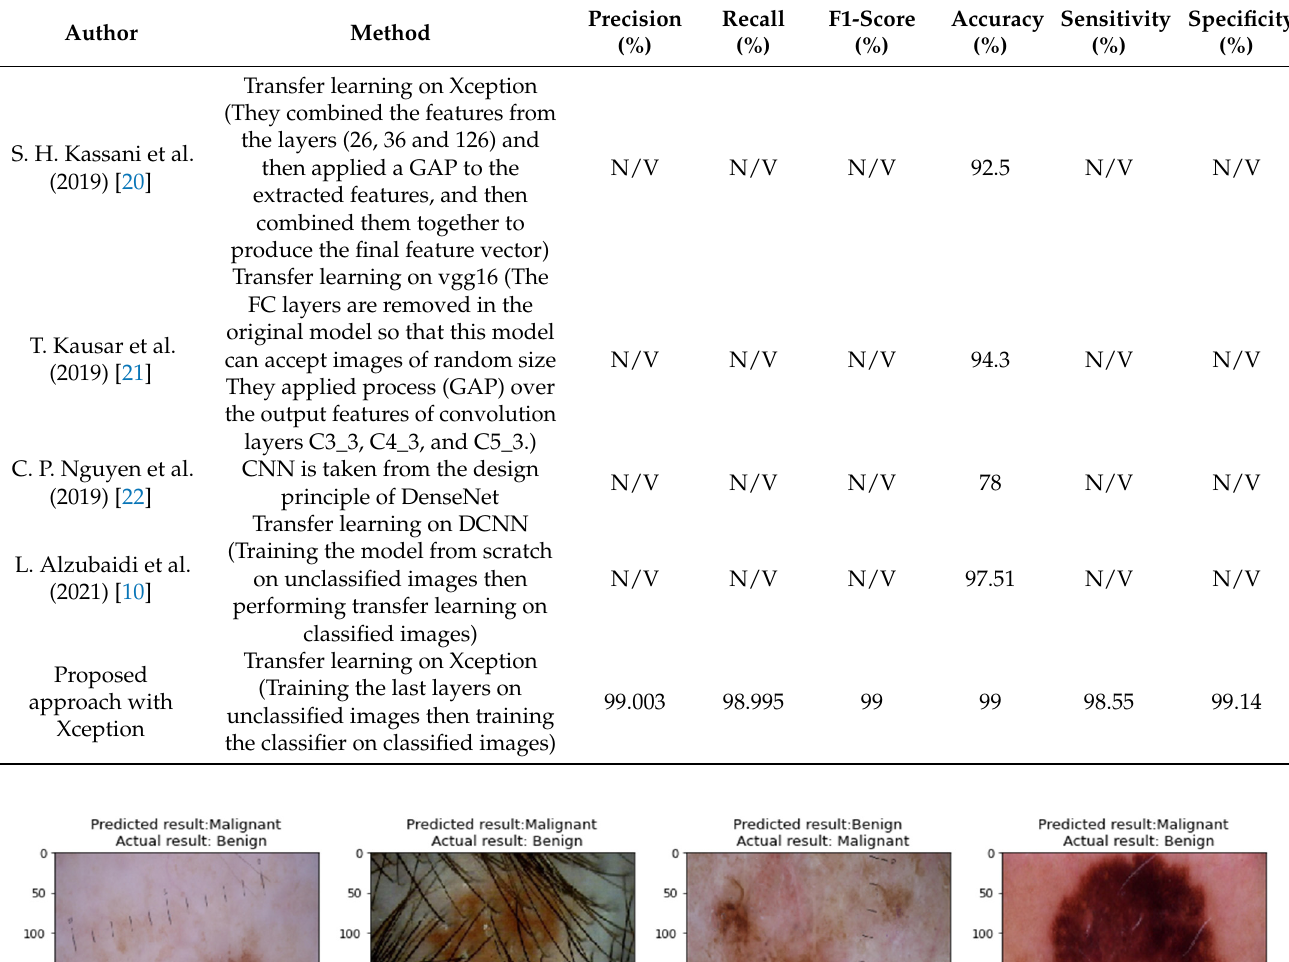
Table 9. Comparison of the results of the proposed approach with related works for the classification of breast cancer images in the ICIAR-2018 dataset.